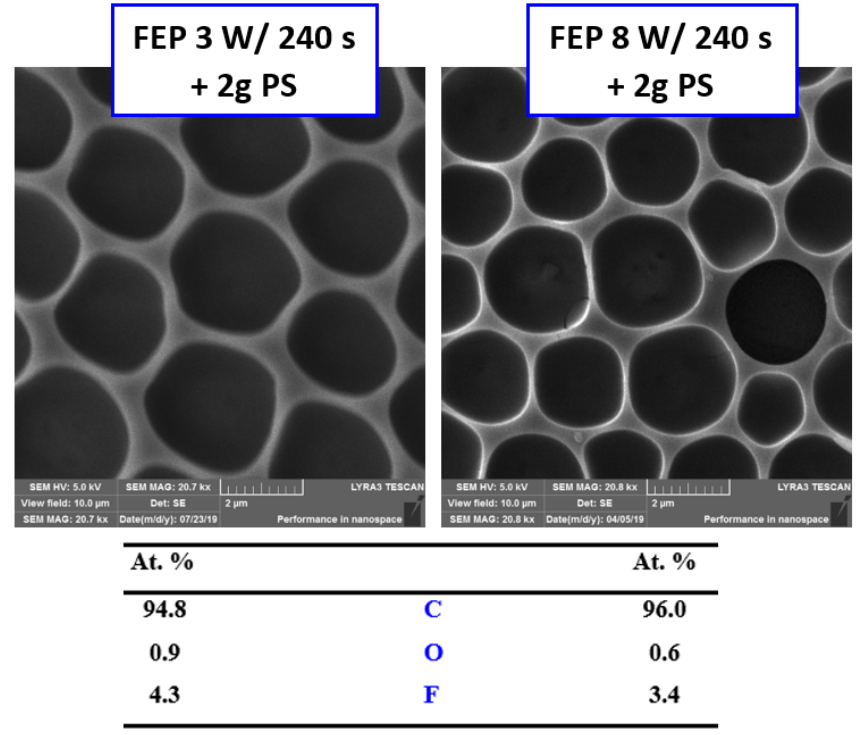
Figure 4. SEM scans (10 × 10 µ m 2 ) of plasma-modified FEP with PS HCP treated at different plasma discharge values (3 and 8 W); corresponding EDS graph and table of element concentrations on the surface.